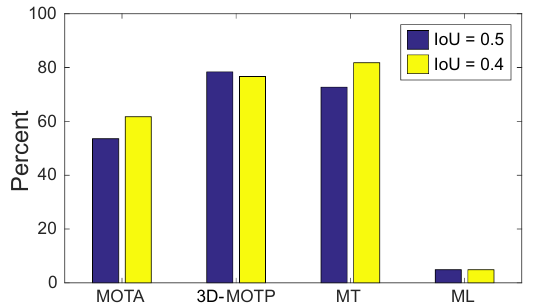
Figure 7. Examples of inaccurate references of the Kitti data (green boxes). Our detections (red boxes) cover the pedestrians better.